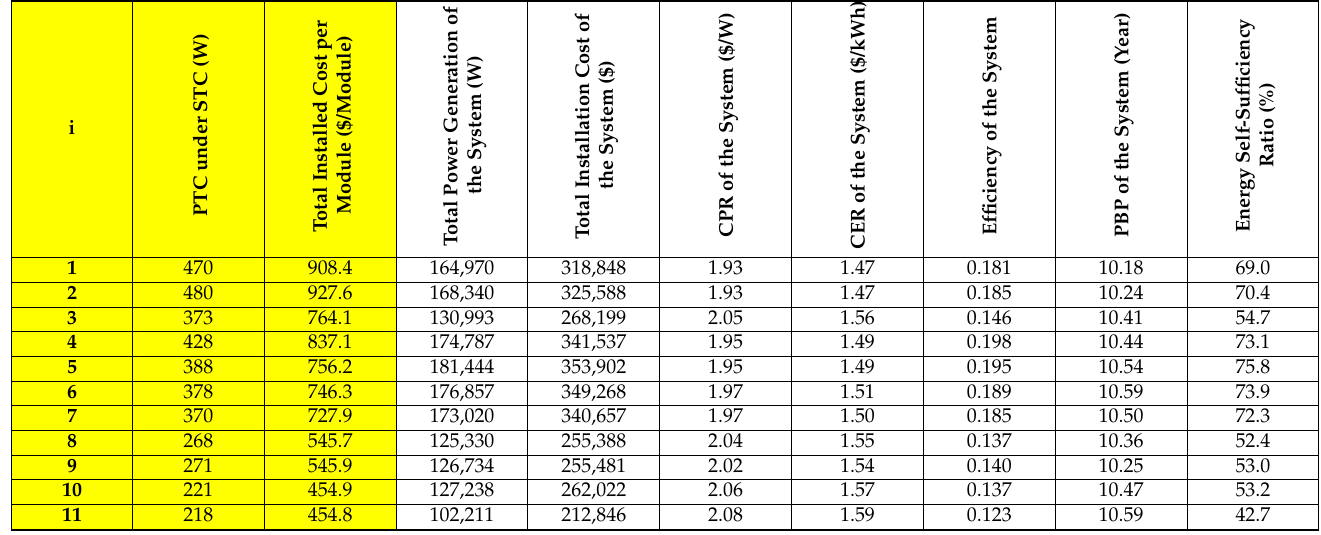
Table 3. Decision matrix used for our proposed rank-weigh-rank (RWR) optimization algorithm.